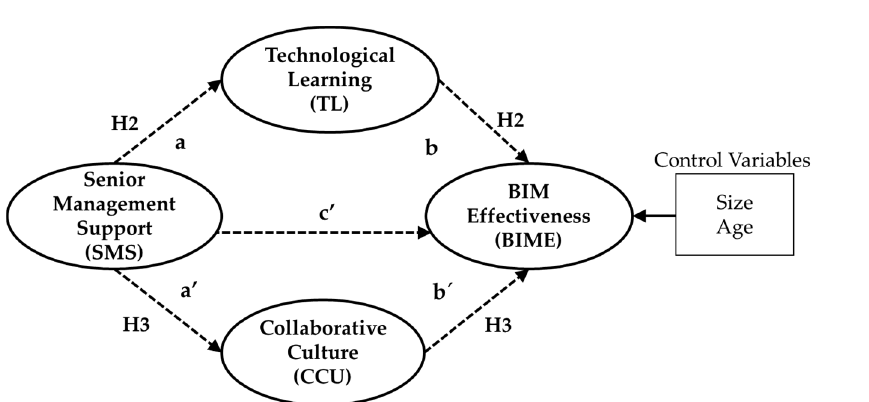
Figure 3. Mediated effects model.